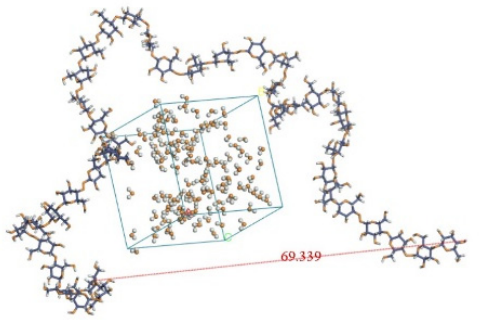
Figure 4. End-to-end distance of water–cellulose model.